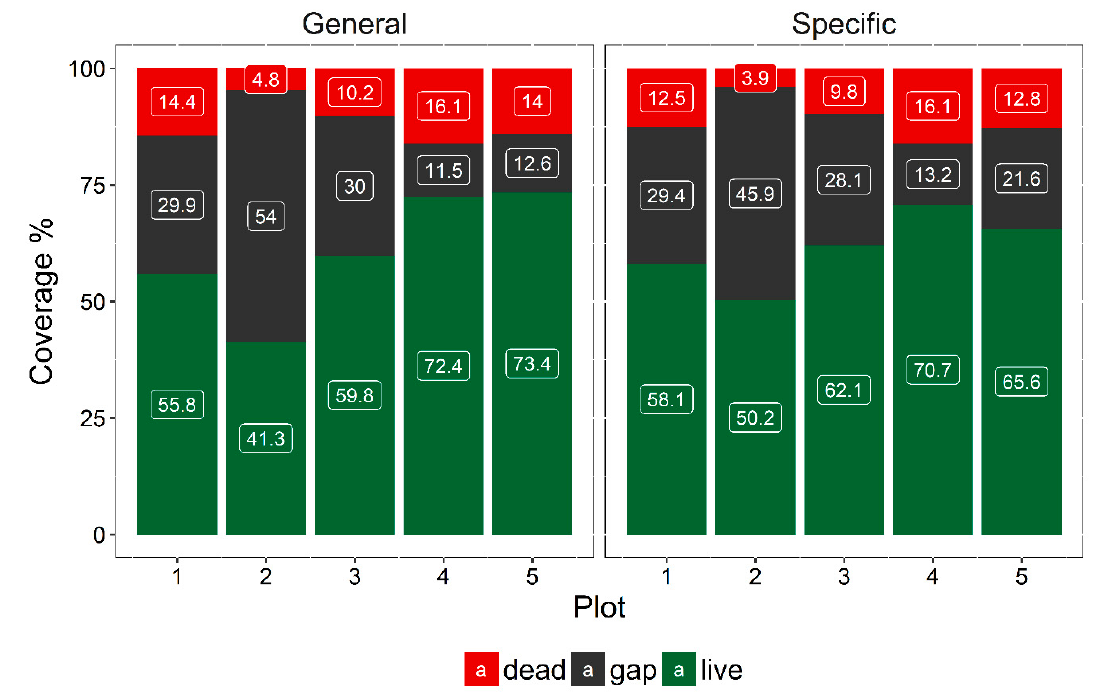
Figure 5. Class coverage of the general and specific models of the five plots of the study area.